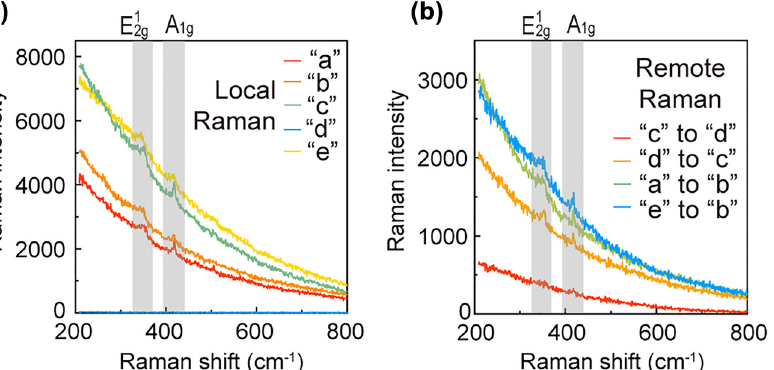
SERS realized by NCoM pairs. Local (a) and remote (b) Raman scattering spectra from NCoM pairs. Grey shades mark Figure 5: Remote WS 2 ( ∼ 420 cm − 1 ) and E 1 ( ∼ 350 cm − 1 two prominent Raman modes: A 1g 2g